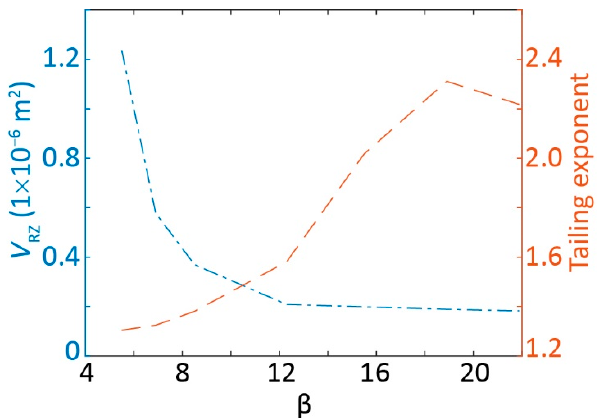
Figure 5. The relationships between the volume of recirculation zone ( V RZ , in blue) and power law function exponent (in orange) against the dimensional hydraulic shape factor β .